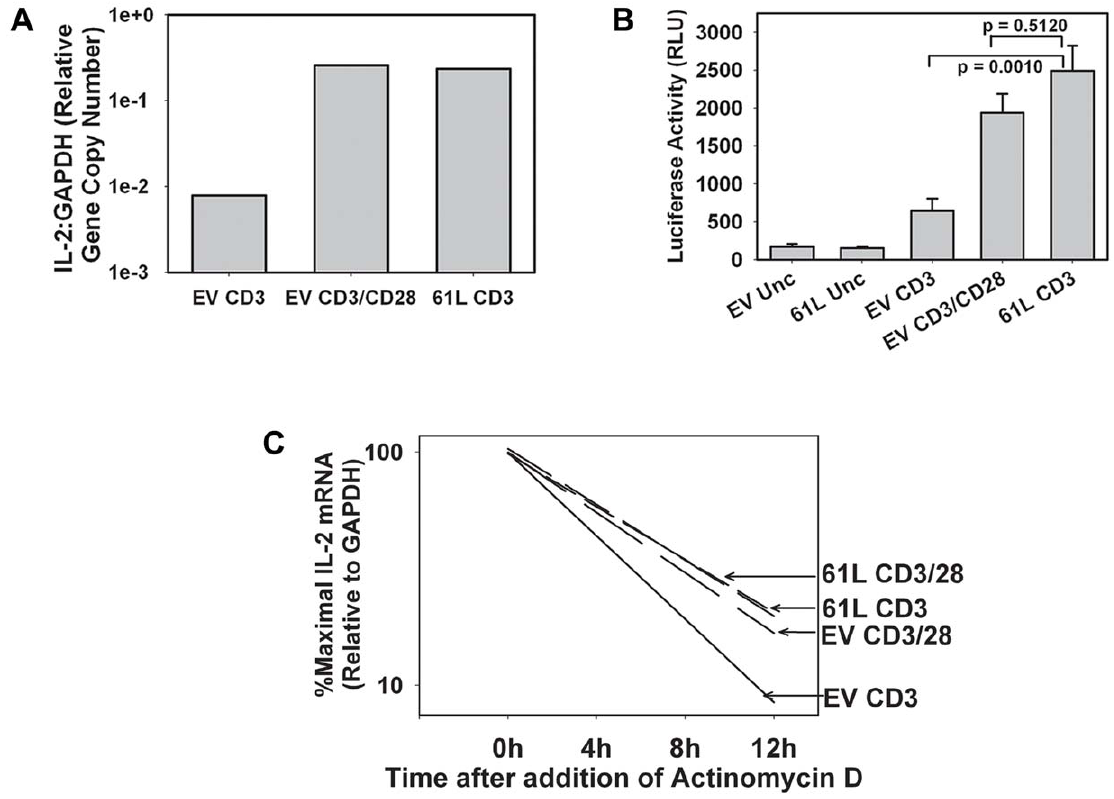
Figure 5. The mechanism of active Ras-mediated IL-2 costimulation mimics the mechanism of CD28-mediated costimulation. A. CAR Tg Th1 T cells were transduced and stimulated for four hours with antibody-coated beads as indicated. IL-2 mRNA production was assessed by real- time RT-PCR analysis of trizol lysates. B. CARTg/Luc Tg Th1 T cells expressing an IL-2 promoted-driven luciferase transgene were transduced and stimulated in triplicate overnight with antibody-coated beads as indicated. Luciferase activity was measured as a marker for IL-2 transcription as described in Materials and Methods. P values shown indicate a significant increase in luciferase activity when active Ras is added to CD3 stimulation and no significant difference in luciferase activity between Ras-transduced cells stimulated through CD3 alone and empty vector transduced cells stimulated through CD3 and CD28. C. CAR Tg Th1 T cells were transduced and stimulated as in A. Actinomycin D was added after 4 hours to stop further transcription. IL-2 mRNA levels were assessed at the time points indicated by real-time RT-PCR. Degradation curves were generated by linear regression modeling of real-time PCR data. Error bars shown indicate standard deviation of the mean between triplicate samples from the same experiment.